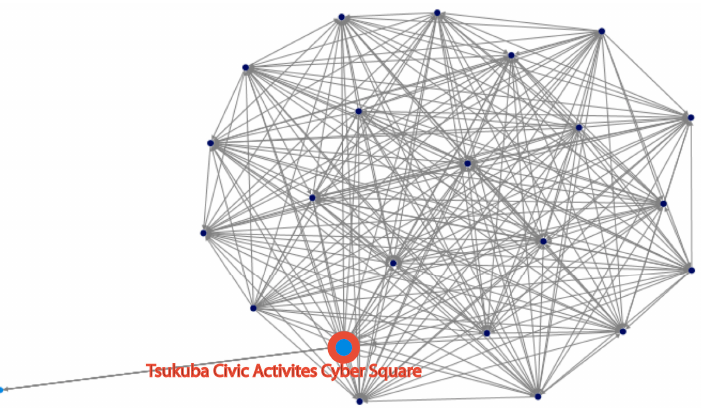
Figure 4. Node XL analysis result map of Social Welfare (25 January 2016).